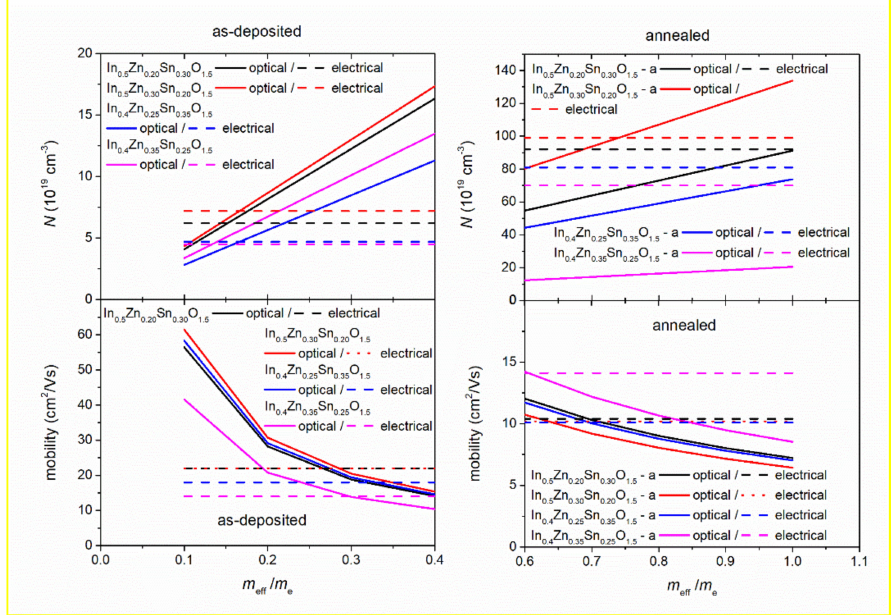
Figure 7. Dependence of free carrier concentration, N , and mobility, µ , calculated from simple Drude oscillator (solid lines) and results from electrical characterization (dashed and dotted lines) on effective mass ( m e is mass of the free electron) for non-stoichiometric as-deposited and annealed IZTO